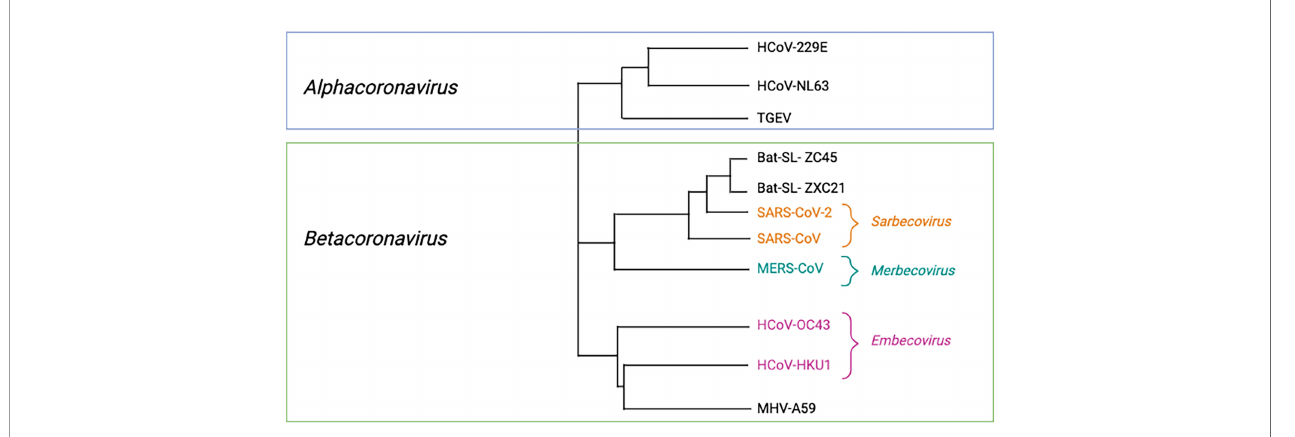
FIGURE 2 | Phylogeneic tree of relevant Orthocoronaviruses. Phylogenetic tree with representative species CoVs. Virus names: HKU, coronavirus identi fi ed at Hong Kong University; HCoV, human coronavirus; MERS, Middle Eastern respiratory syndrome; MHV, murine hepatitis virus; SARS, severe acute respiratory syndrome; SL, SARS-like; TGEV, transmissible gastroenteritis virus. Created with